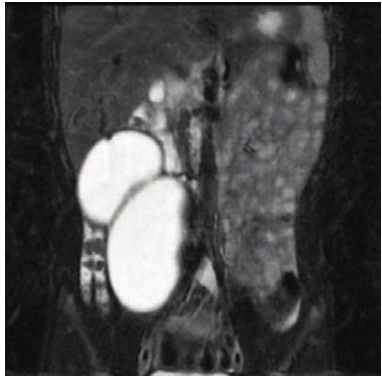
Figure 3. A) Computed tomography scan transversal view of the mass (mesenteric cystic lymphangioma). B) Operative findings demonstrating multiple cysts involving the jejunoileal mesentery. Total excision of the lesion required a segmental bowel resection.